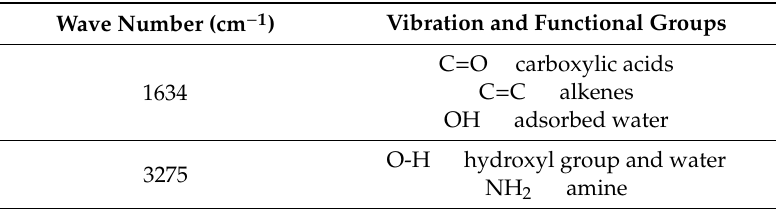
Table 2. Functional groups or compounds analyzed by Fourier transform infrared spectroscopy (FTIR) analysis in raw and EF-pretreated